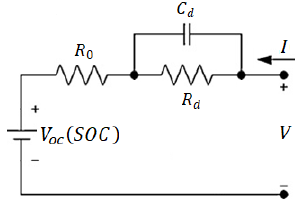
Figure 12. Adopted equivalent-circuit battery model.